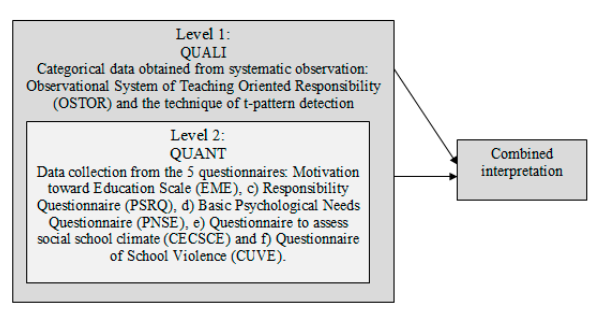
Figure 1. Multilevel triangulation design adapted from Creswell et al. [25] (p. 64) and Camerino et al. [26] (p. 12).